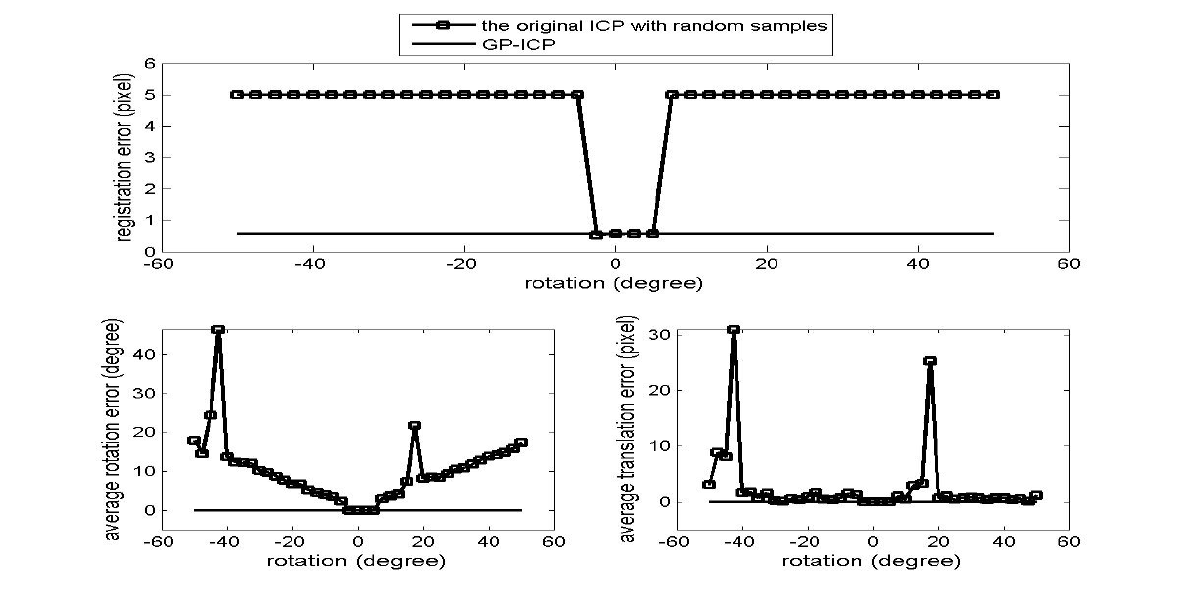
Figure 1. Convergence region test of the point clouds from the cactus without translation.